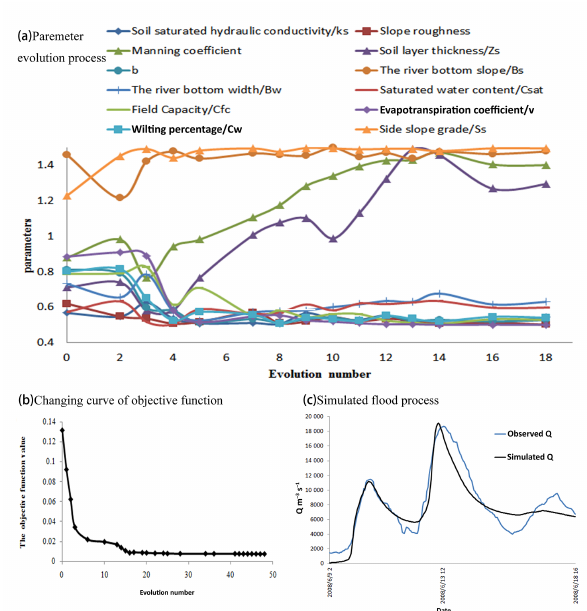
Figure 4. Parameter optimization results of Liuxihe model for LRB with PSO